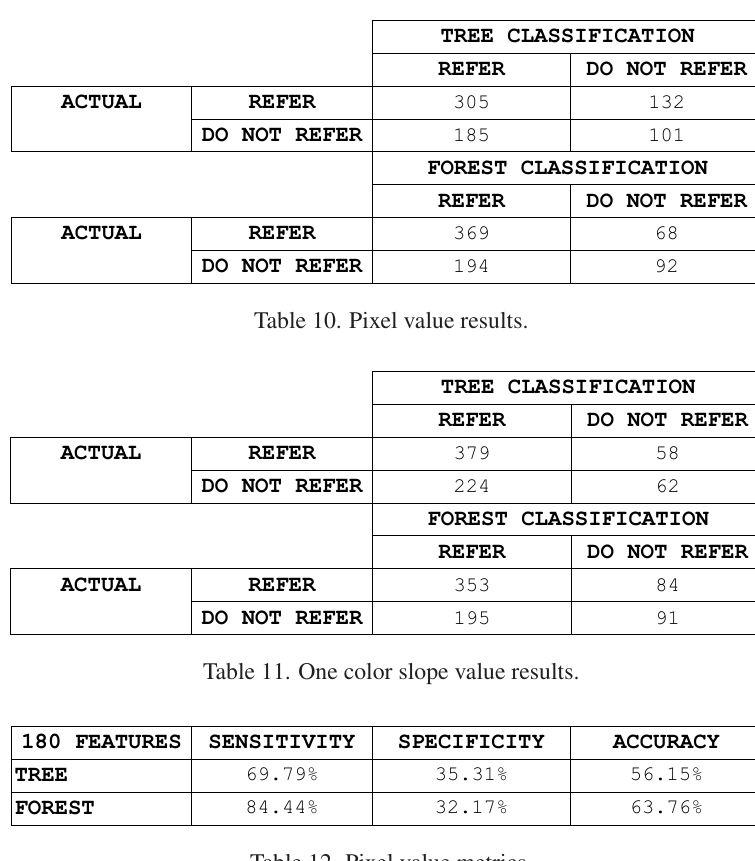
Table 12. Pixel value metrics.